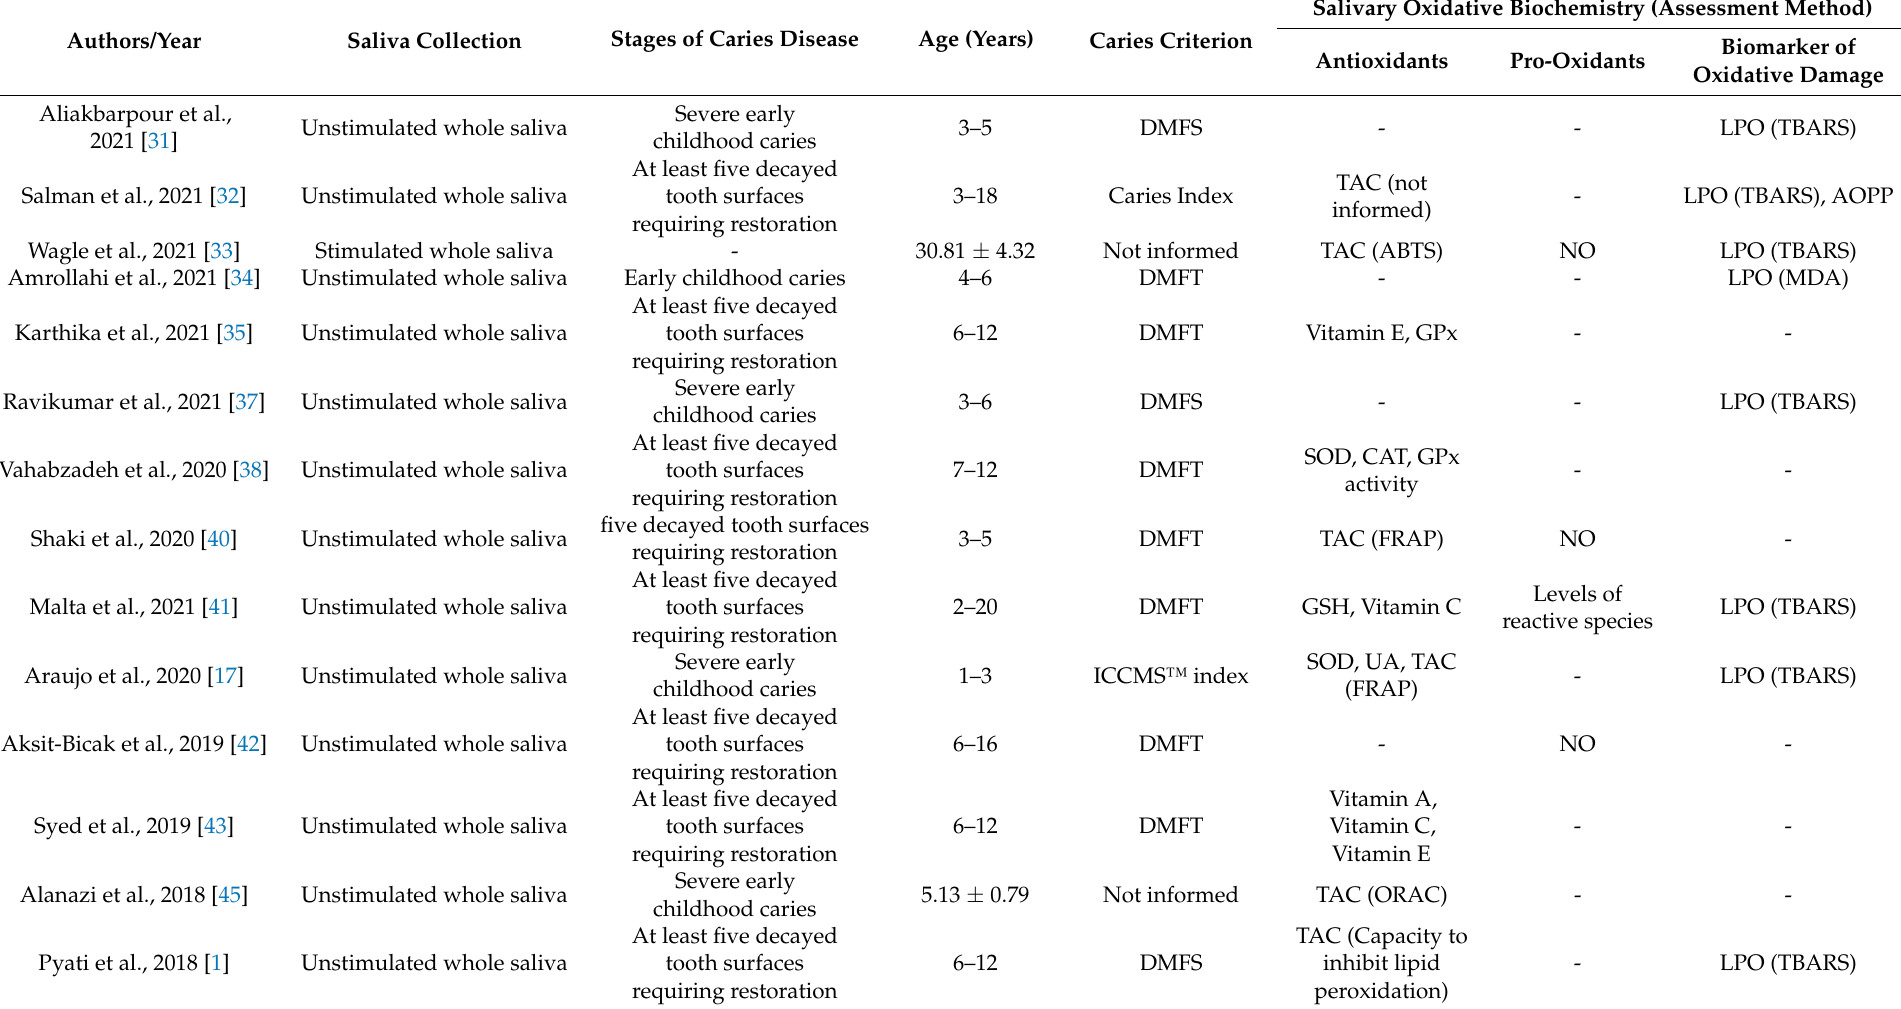
Table 4. Evaluated parameters of saliva collection, caries, and oxidative biochemistry salivary in original